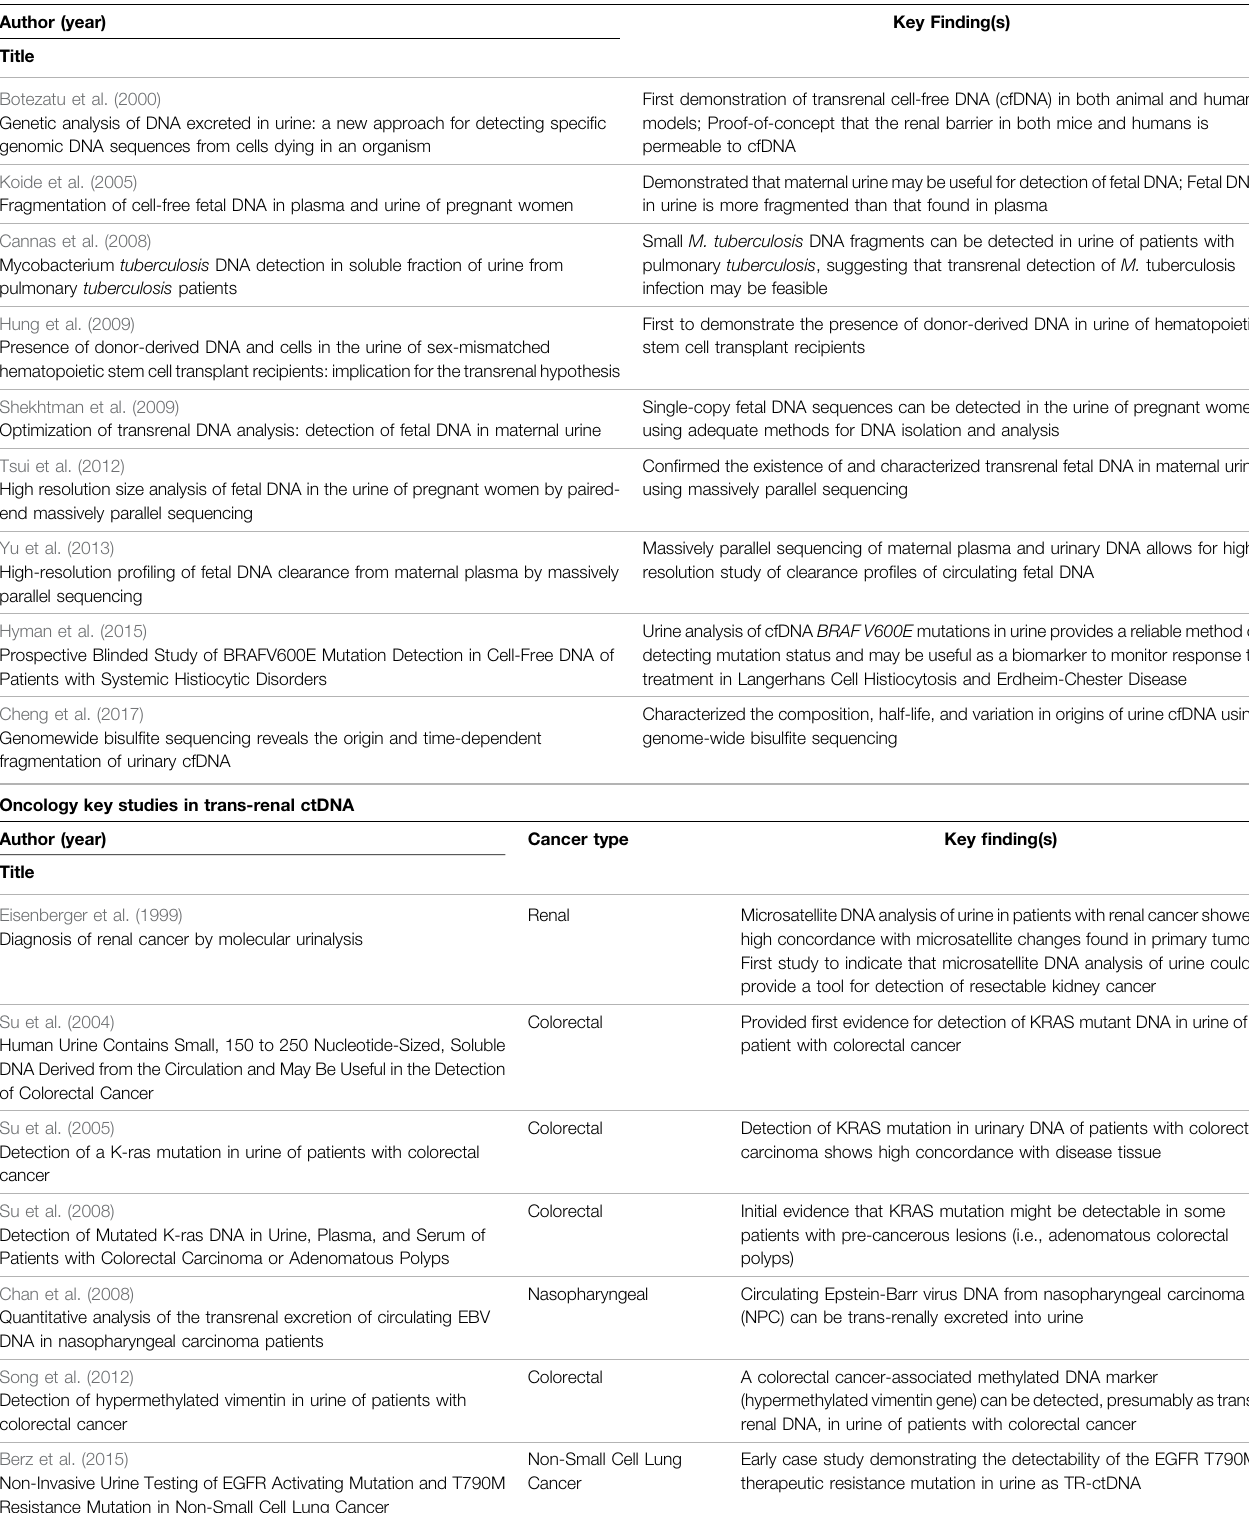
TABLE 1 | Key Trans-Renal cell-free DNA Studies in Non-Oncology and Oncology Contexts. Non-oncology key studies in trans-renal